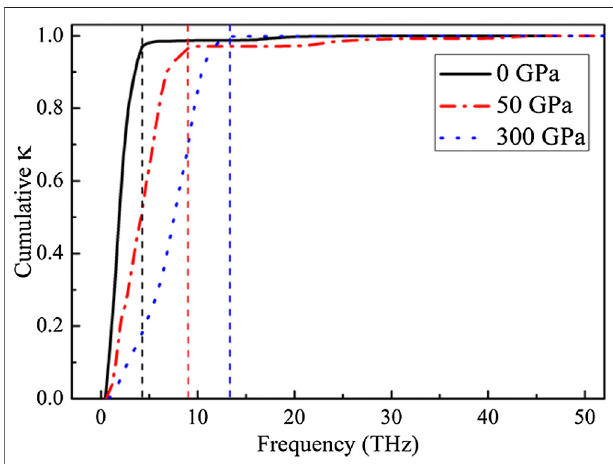
FIGURE5| NormalizedaccumulativethermalconductivityforYH 3 under different pressures. The vertical dashed lines highlight the upper bound of acoustic branches for different YH 3